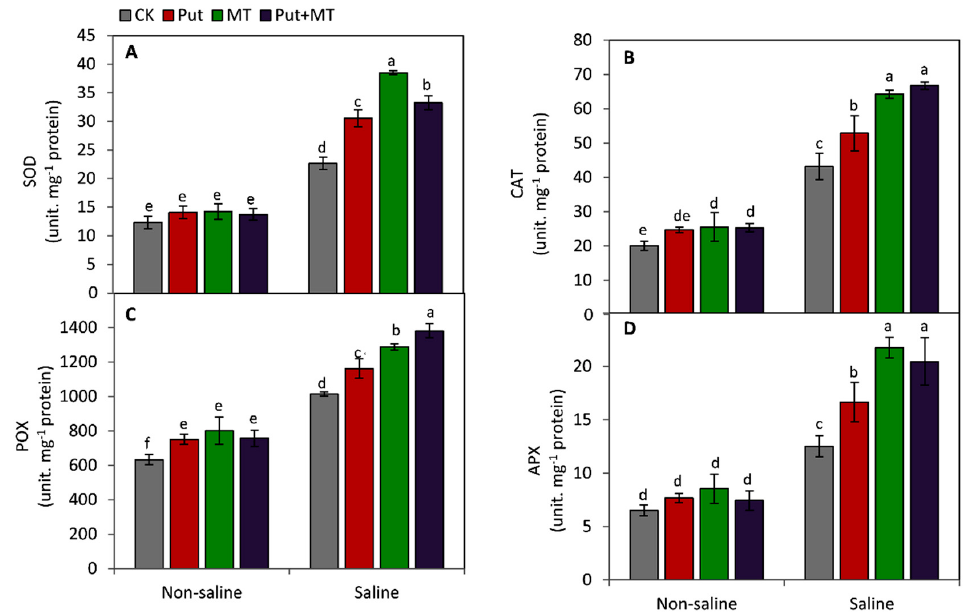
Figure 5. Effect of melatonin (MT; 20 µ M), putrescine (Put; 100 µ M), and their combination on the activities of antioxidant enzymes of snap bean seedlings grown under control and salt stress (50 mM NaCl). ( A ) Superoxide dismutase (SOD), ( B ) catalase (CAT), ( C ) peroxidase (POX), and ( D ) ascorbate peroxidase (APX). The upper error bar denotes standard deviation, while various lowercase letters above the bars denote significant differences according to Duncan’s multiple range tests ( p ≤ 0.05).